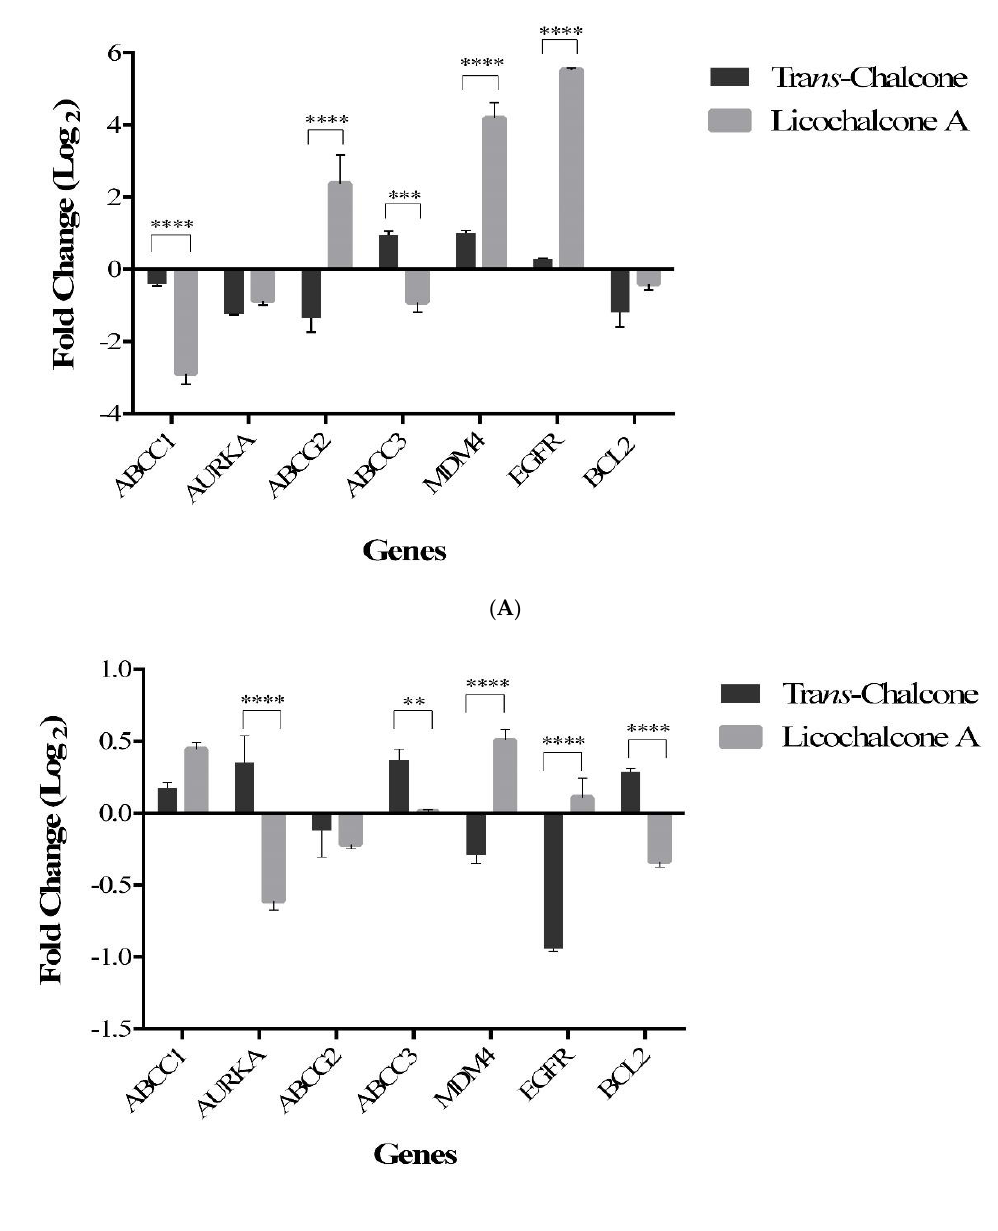
Figure 3. Analysis of the transcriptional profile by qRT-PCR in ( A ) MCF-7 cell line and ( B ) BT-20 cell line. The data represent the mean ± SD of three experiments. ** p ≤ 0.01, *** p ≤ 0.001 and **** p ≤ 0.0001. The asterisks represent significant difference between chalcones.